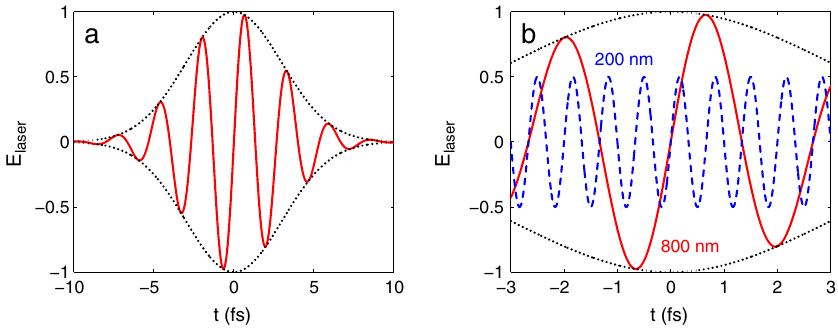
FIG. 2. (Color) (a) A snapshot of the laser field normalized to the peak value for the 800 nm few-cycle laser with pulse length 5 fs (FWHM of intensity). (b) Schematic of the synchronization between the laser in M2 and the few-cycle laser (laser field not in scale).